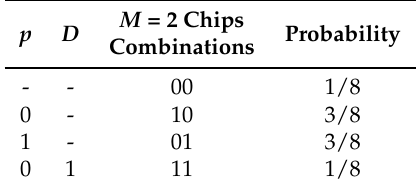
Table 1. Probabilites of M = 2 asynchronous